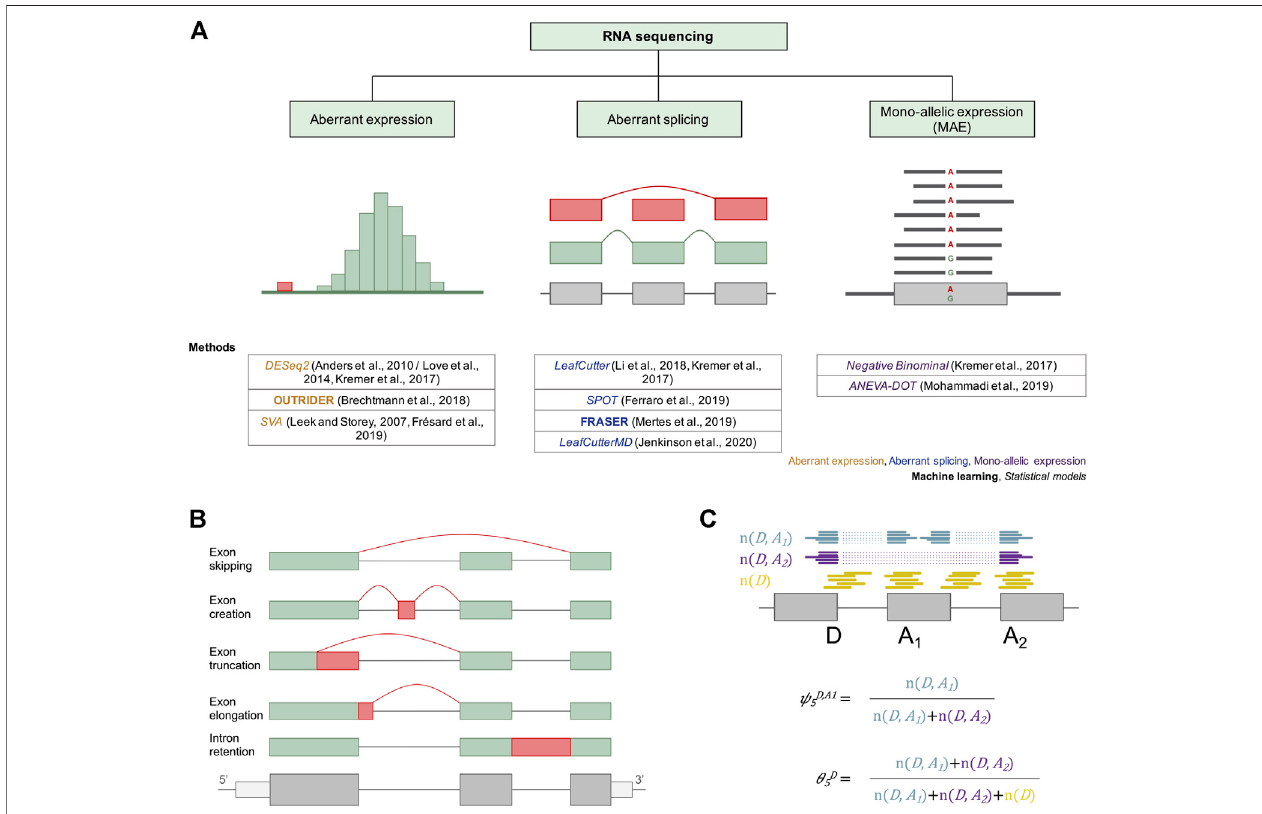
FIGURE 2 | Current approaches for the molecular diagnosis of rare genetic disorders via RNAseq. (A) Different machine learning and statistical approaches have beenadaptedordevelopedandappliedtofacilitatediagnosis via aberrantexpression,aberrantsplicing,andmono-allelicexpressiondetection.Foraberrantexpression, thedistributionofreadcountsisdepicted,withoutliersinred.Fordetection ofaberrant splicing,anexonskippingeventisdepictedinred.Formono-allelicexpression,a SNV with MAE of the alternative allele A is shown. Below each diagram the different methods used to detect RNAseq outliers of the corresponding cases are provided. (B) Different types of alternative splicing scenarios are depicted. Different mRNA isoforms can be generated from a single pre-mRNA through exon skipping, exon creation, exon truncation, exon elongation, and intron retention. Exons are represented as green and red boxes. Introns are illustrated as solid lines between the boxes. (C) A subset of a gene model is shown with split reads going from splice donor D to splice acceptors A 1 (blue) and A 2 (purple), and non-split reads spanning the exon – intron boundary at the splice donor D (yellow). These reads can then be converted into the percent spliced-in ( ψ ) and the splicing ef fi ciency ( θ ) metrics using the formulae below the gene